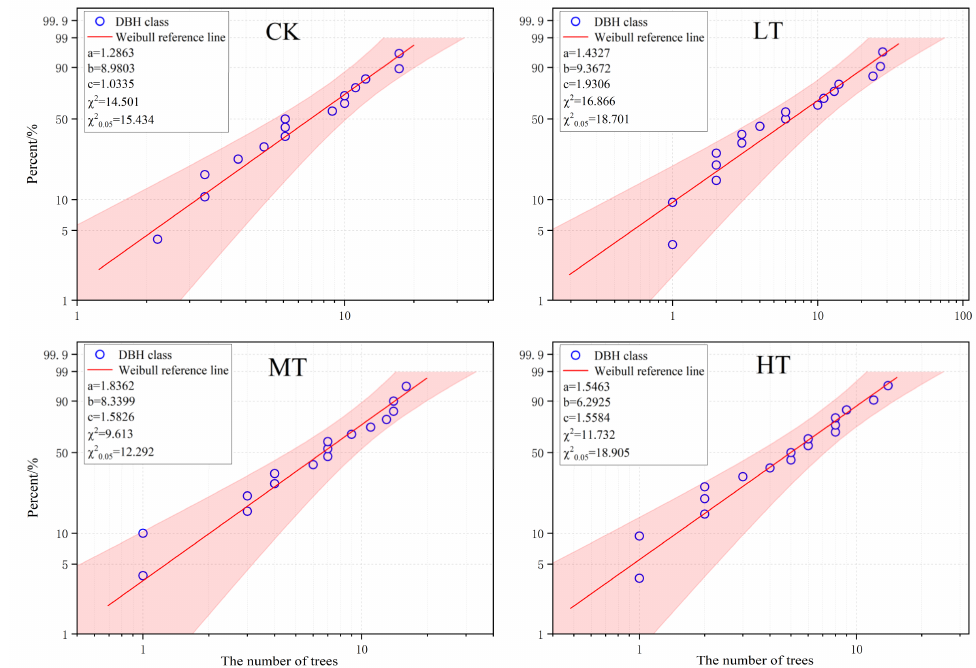
Figure 2. DBH frequency of Weibull distribution under different treatments. The results were subjected to χ 2 test, and then the fitting results were